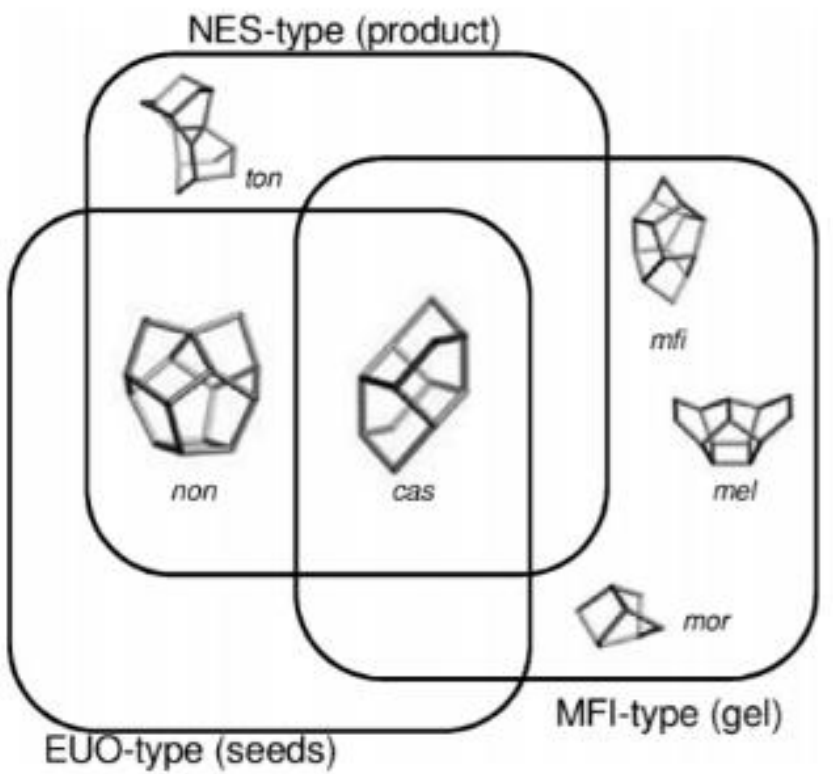
Figure 3. Correlation of the composite building units (CBUs) in NES-, EUO- and MFI-type zeolites. Reprinted with permission from ref. [75]. Copyright 2015, Elsevier.